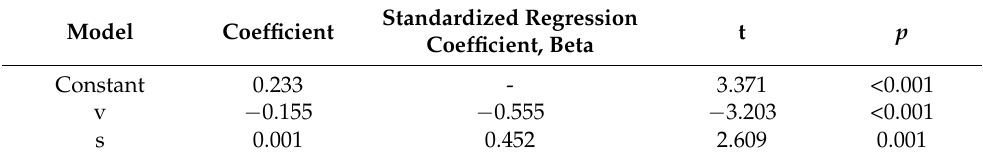
Table 22. Coefficients of the regression model for slurry pot test.